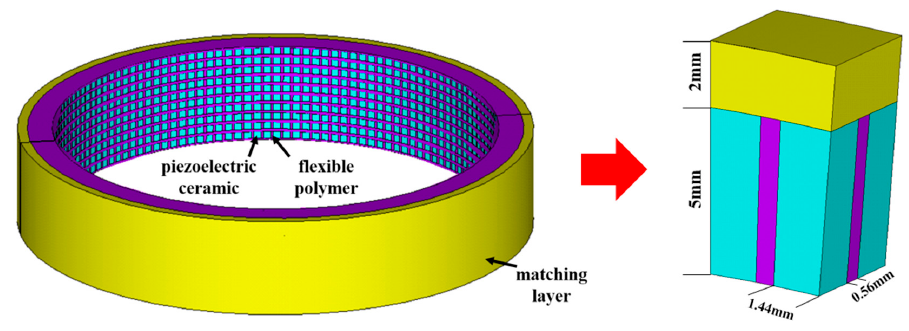
Figure 2. The structure of 1-3 type piezoelectric composite material with matching layer.